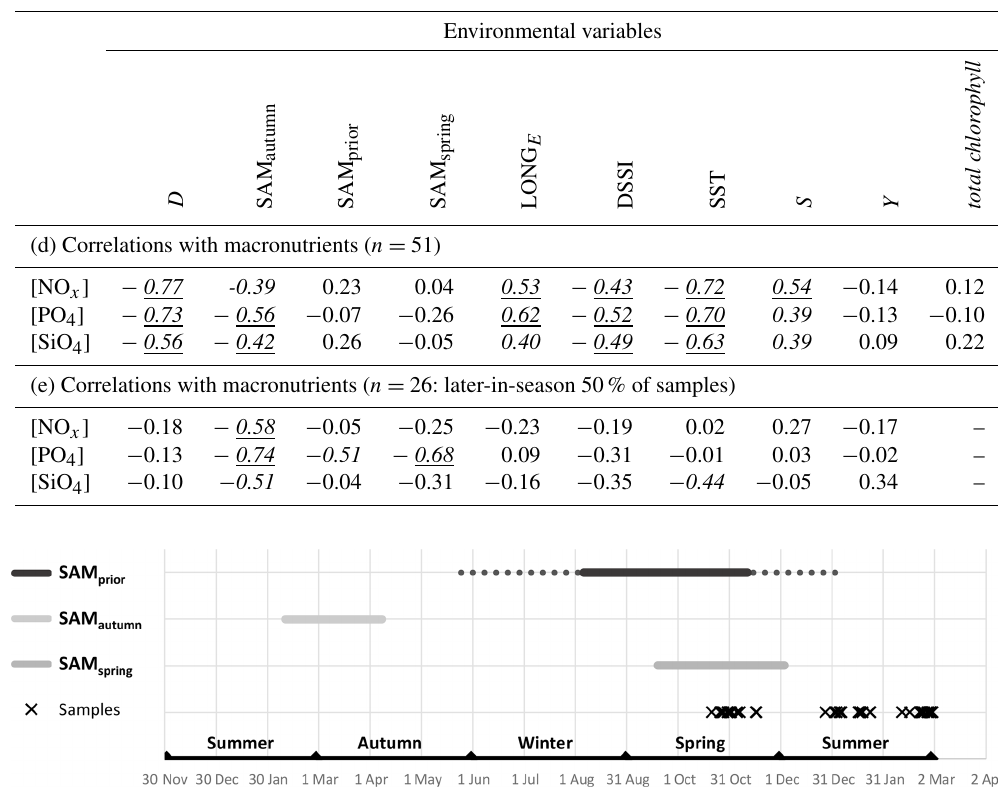
Figure 4. Maxima of SAM influence on phytoplankton community composition. SAM prior was determined relative to sample collection: the depicted solid line represents the average temporal location of the 97d period and the broken lines represent the earliest and latest extent of the range associated with the earliest and latest